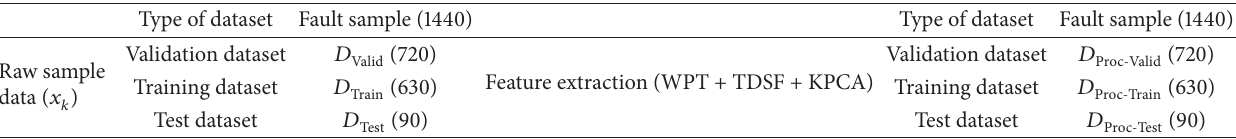
Table 2: Division of sample dataset into different subsets.